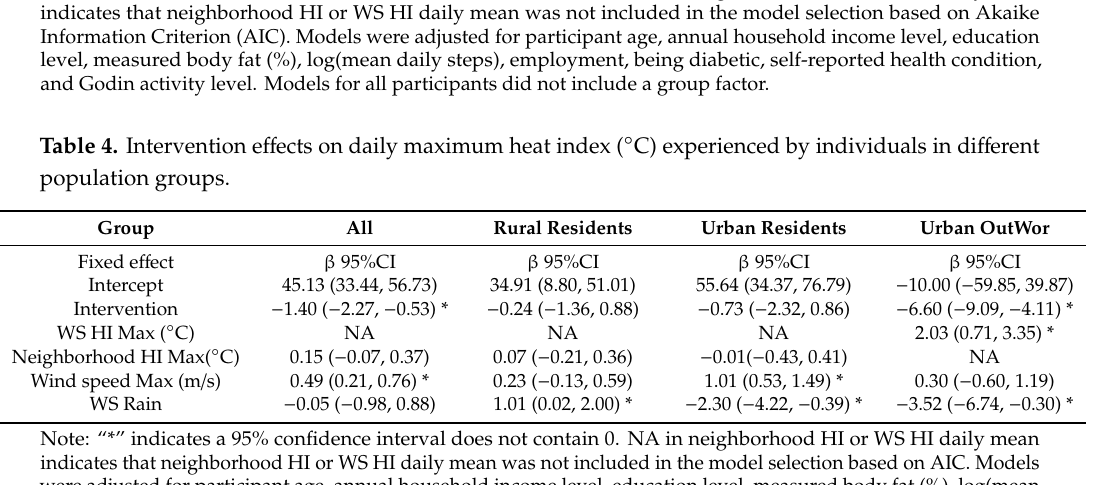
Table 3. Intervention e ff ects on daily mean heat index ( ◦ C) experienced by individuals in di ff erent population groups. Group All Rural Residents Urban Residents Urban OutWor Fixed e ff ect β 95%CI β 95%CI β 95%CI β 95%CI Intercept 24.45 (19.23, 29.67) 24.47 (15.99, 32.96) 31.58 (22.02, 41.12) 5.43 ( − 7.78, 18.63) Intervention − 0.59 ( − 0.88, − 0.30) * − 0.49 ( − 0.89, − 0.09) * − 0.28 ( − 0.80, 0.24) − 1.74 ( − 2.38, − 1.09) * WS HI Mean ( ◦ C) NA NA NA 0.95 (0.59, 1.31) * Neighborhood HI Mean ( ◦ C) 0.21 (0.09, 0.34) * 0.01 ( − 0.19, 0.22) 0.04 ( − 0.17, 0.25) NA Wind speed Mean (m / s) 0.69 (0.23, 1.15) * 0.93 (0.22, 1.64) * 0.56 ( − 0.16, 1.29) 1.51 (0.39, 2.63) * WS Rain 0.24 ( − 0.08, 0.55) 0.32 ( − 0.06, 0.69) 0.03 ( − 0.62, 0.67) 0.06 ( − 0.80, 0.92)